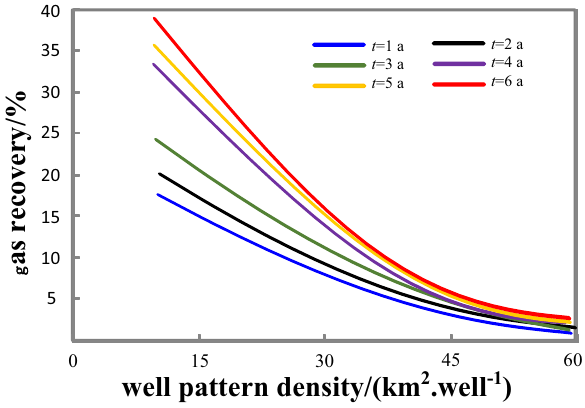
Fig. 6 The curves of gas recovery and well pattern density versus